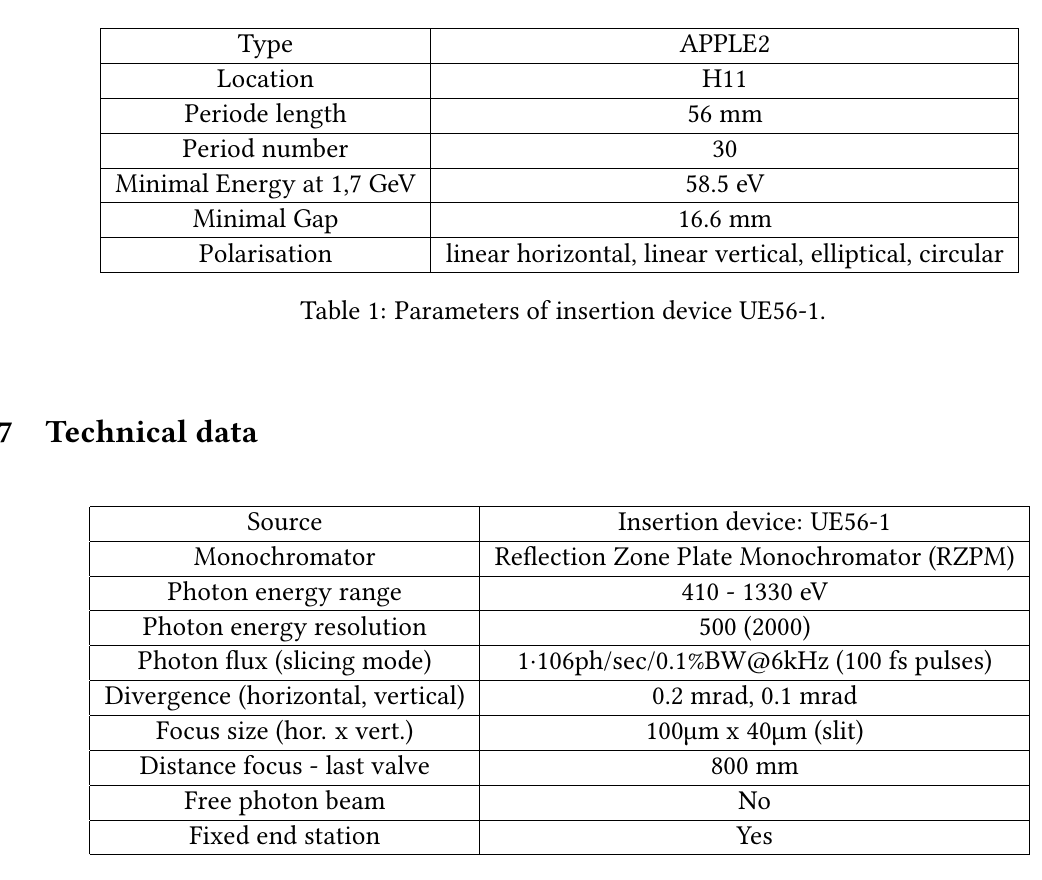
Table 2: Technical data of the Beamline UE56-1